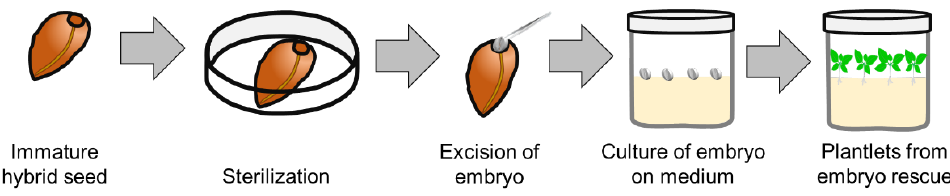
Figure 4. Process of embryo rescue from immature (or non - viable) seed after hybridization.